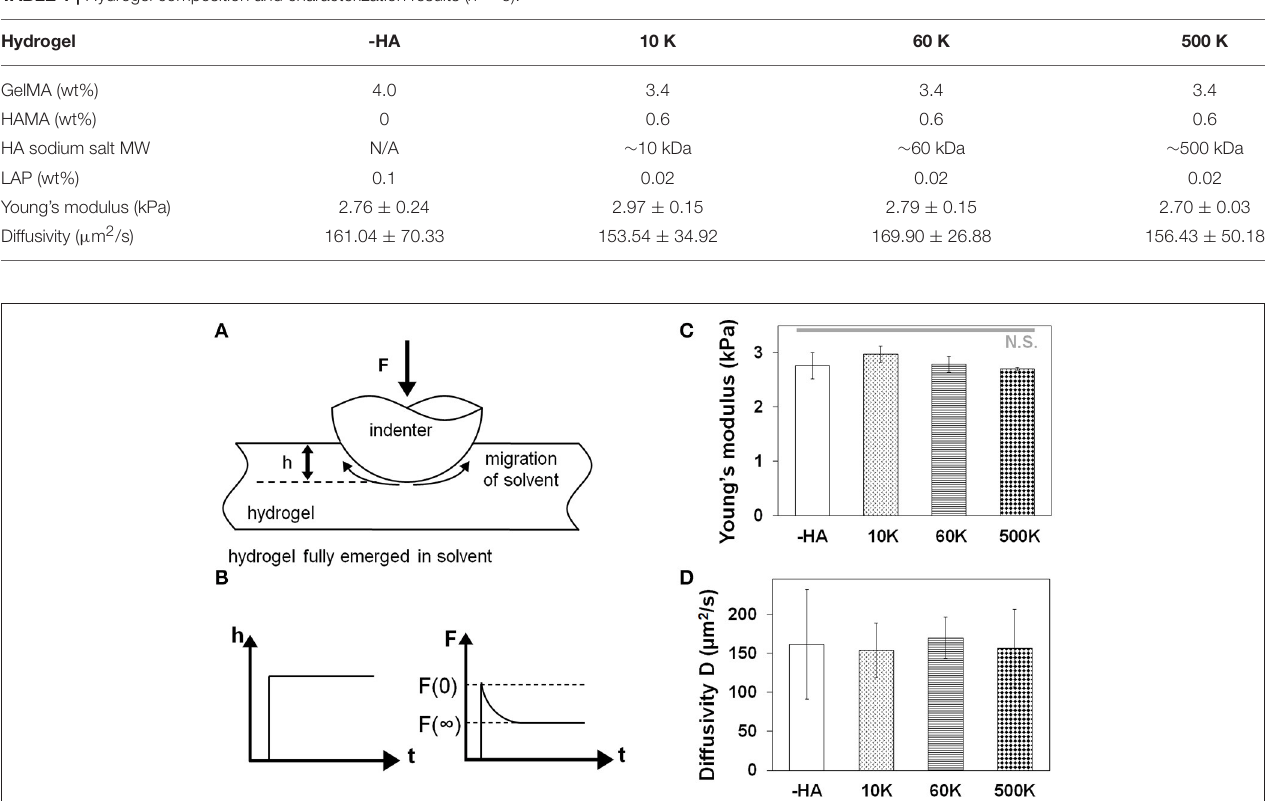
FIGURE 1 | (A) Schematic drawing of measuring hydrogel water diffusivity via AFM. (B) Poroelastic parameters are extracted via indentation performed to a fixed depth followed by force relaxation to a new equilibrium state. Characterization that for a homologous series of GelMA hydrogels developed for this project there was a negligible effect of the molecular weight of hyaluronic acid incorporated into the GelMA hydrogel on (C) hydrogel Young’s modulus measured via MTS ( n hydrogel diffusivity via AFM ( n =